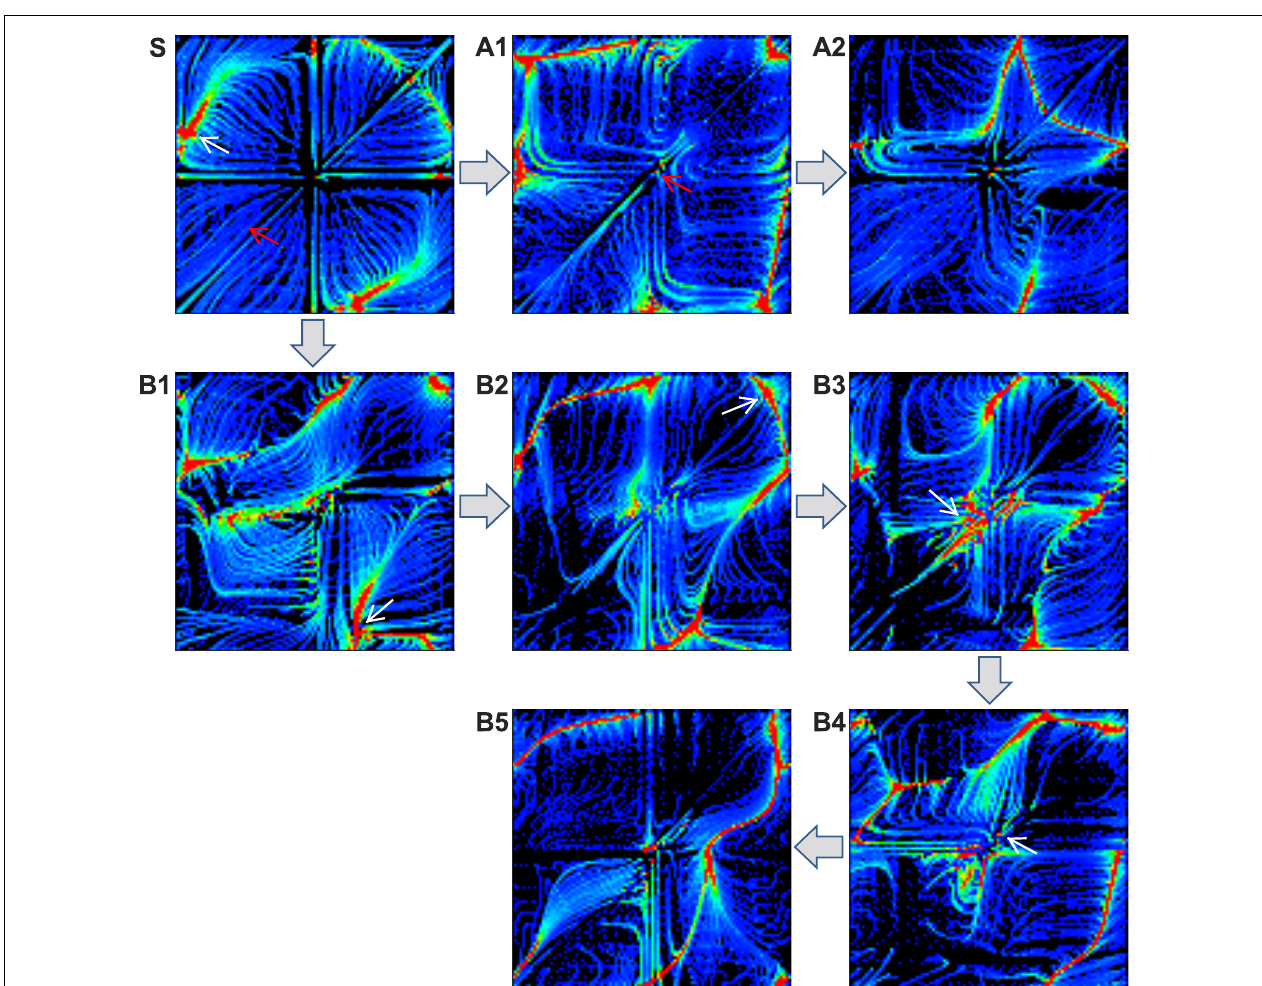
(intentionally fixed to the highest performing pattern), only the stable patterns were selected on the corresponding landscapes, i.e., one of the red colored regions which is found by running the system for sufficient duration.Two example sequences of landscape deformations are shown: S-A1-A2 (indicated by patterns with red arrows) and S-B1-B2-B3-B4-B5 (white